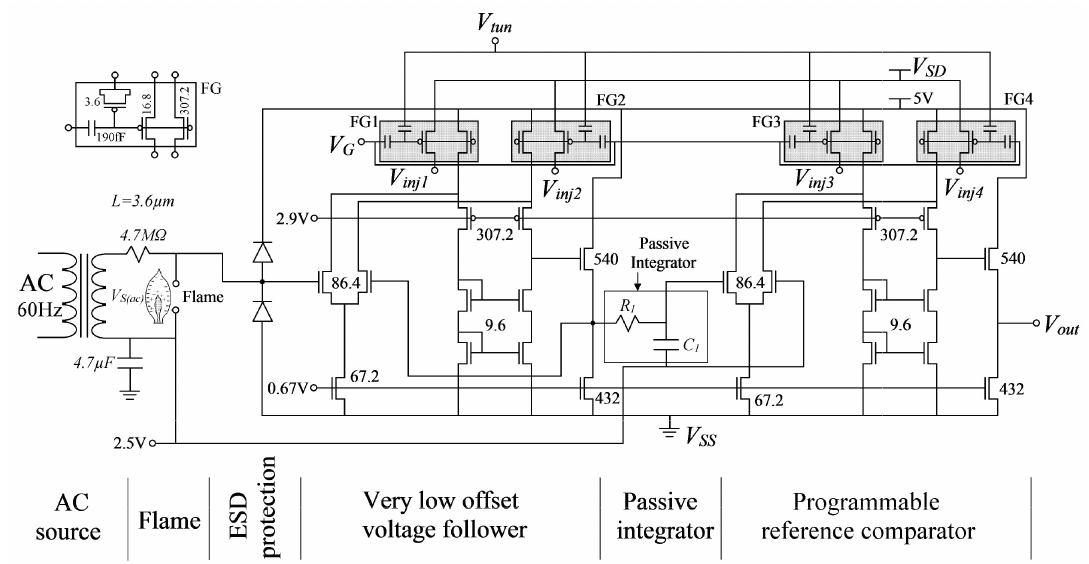
Figure 2. The flame detecting sensor using CMOS technology and Floating Gate Transistors. The AC voltage is applied through the flame by means of a metal rod and a burner. The two Programmable Offset Operational Amplifiers and the integrator’s network are clearly shown.